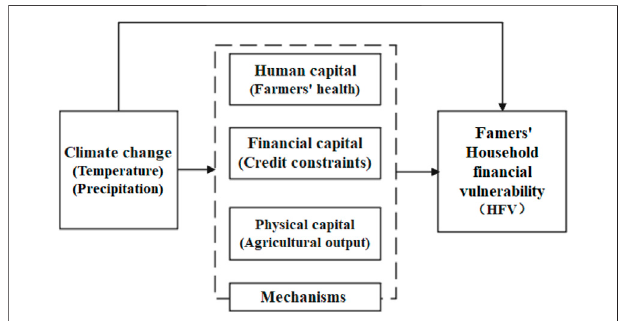
FIGURE 1 | The mechanisms of climate change ’ s effects on